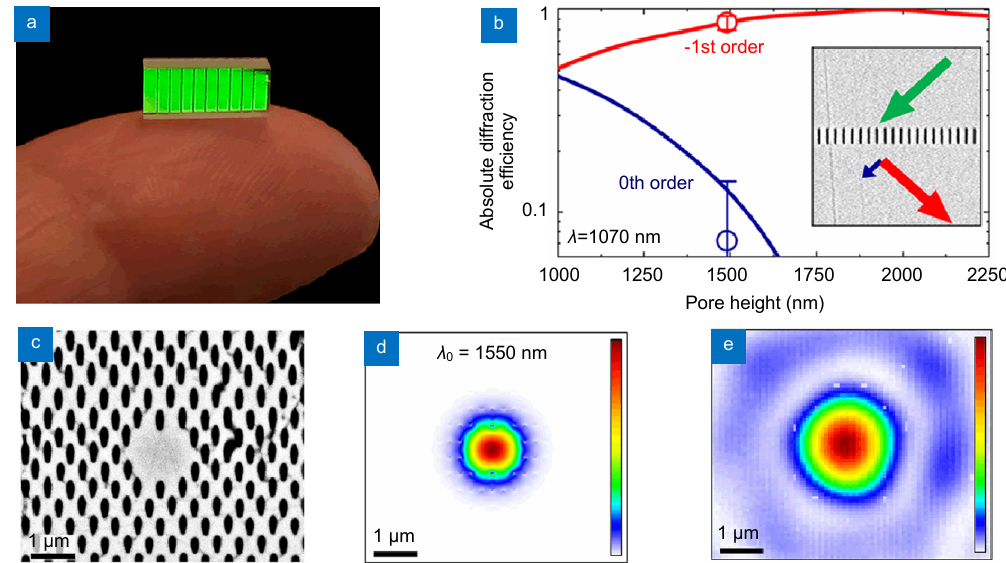
Fig. 5 | Subwavelength gratings and optical waveguide fabricated in YAG crystals by wet etching assisted femtosecond laser modifi- cation. ( a ) Optical images of the gratings with centimeter-long and 700 nm-pitch. ( b ) Diffraction efficiency of the gratings with a wavelength of 1070 nm. The insert image is the SEM of the fabricated gratings. ( c ) The cross-section SEM image of the optical waveguide in YAG crystal. ( d ) Simulated and ( e ) experimental light intensity mode profiles of the optical waveguide with a wavelength of 1550 nm. Figure reproduced from (a–e) ref. 89 , Springer